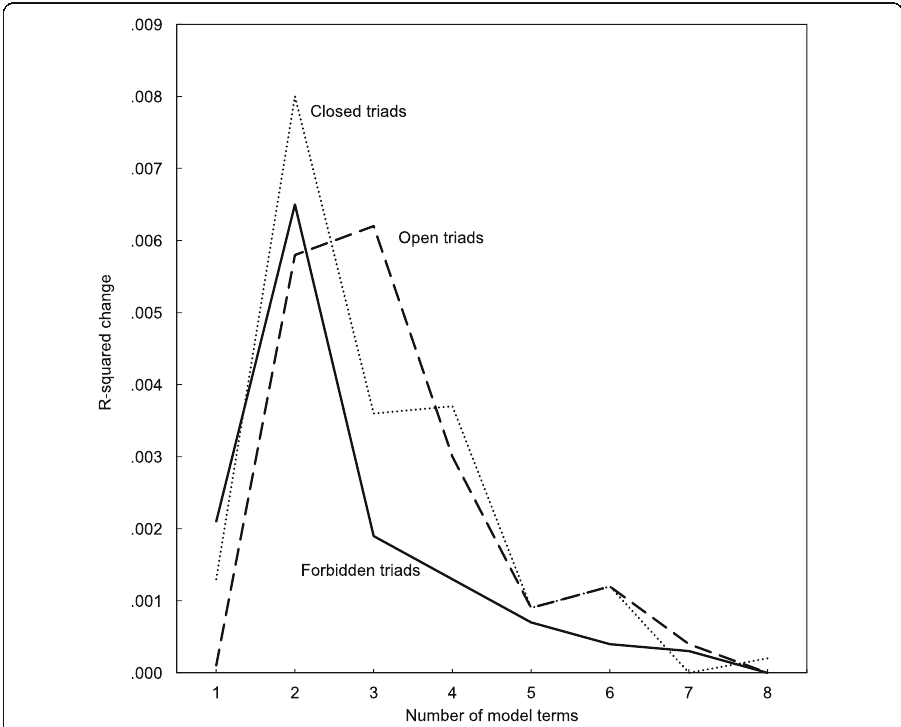
Fig. 6 R-squared change in OLS predictions of the log number of releases by the number of model terms (powers) of triad density